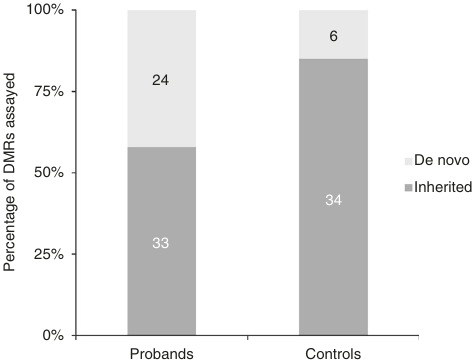
Fig. 2 A signi fi cant excess of de novo epivariations found in patients with ND – CA. We observed a 2.8-fold enrichment for de novo epivariations in cases ( n = 24 out of 57) when compared to controls ( n = 6 out of